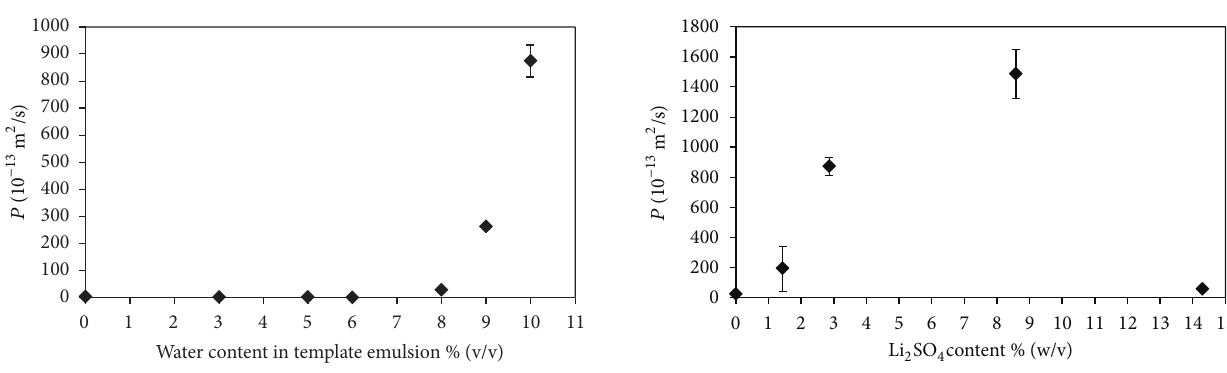
Figure 5: Plot of the water permeability of films casted from template emulsions with varying water content in the emulsion tem- plate. The permeability was normalized against the film thickness. Error bars indicate min/max deviation ( 𝑛 = 2 -3).